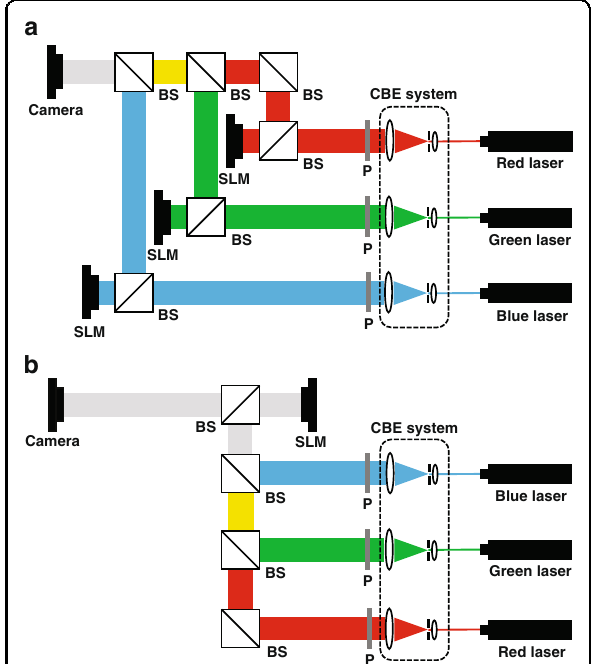
Fig. 8 Optical system of color holographic display. a Spatial- multiplexing method; b time-multiplexing method, where P is polarizer and CBE system is collimating and beam expanding